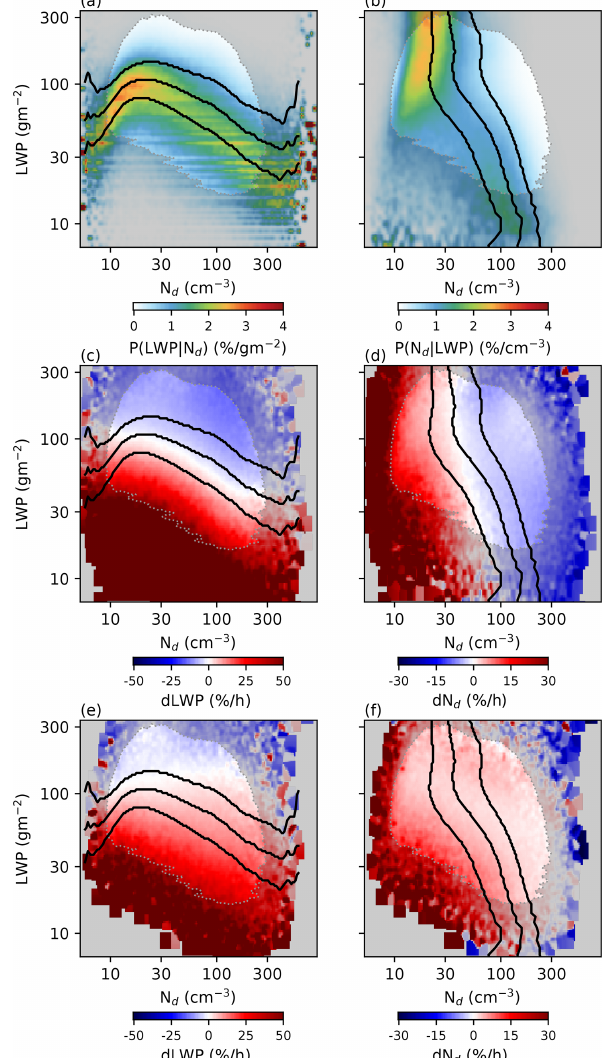
Figure 4. N d –LWP development fields for Namibian stratocumu- lus region (A in Fig. 2a). (a) The probability of observing an ini- tial LWP for a given initial N d ( P (LWP | N d )) and (b) P ( N d | LWP). (c, d) Red is a positive (c) dLWP or (d) d N d for a given initial (morning, Terra) N d and LWP, while blue is negative (decrease in LWP or N d ). The fields are smoothed with a Gaussian window fil- ter. Panels (e, f) are the same as (c, d) but are binned using the final (afternoon, Aqua) N d and LWP. The black lines are at the 25th, 50th and 75th percentiles. Regions with fewer than 30 retrievals per bin are shaded